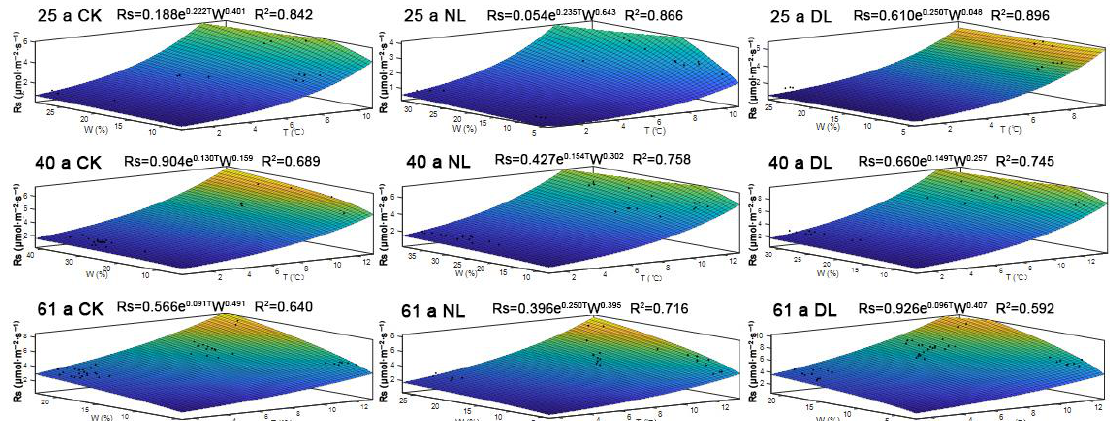
Figure 6. The best-fit models based on the soil temperature (T) and the soil water content (W) for the monthly soil respiration (Rs) rate under litter manipulation of the different-aged Betula platyphylla forests of the permafrost region, Northeast China. Stand ages included 25 ( a ), 40 ( b ) and 61 ( c ). Litter manipulation for each stand included NL (no-litter), DL (double litter) and CK (control litter).